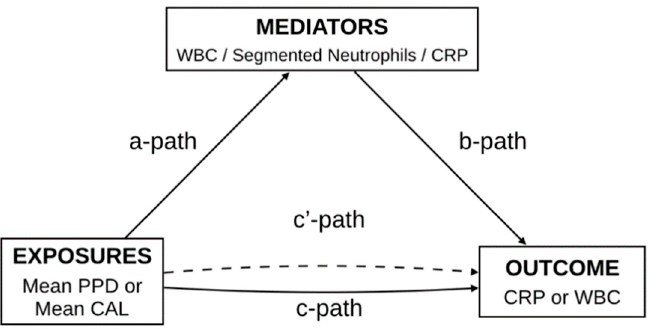
Figure 1. Path diagram of the mediation analysis models. CAL—Clinical Attachment Loss; CRP—C- Figure 1 . Path diagram of the mediation analysis models. CAL – Clinical Attachment Loss; CRP – reactive protein; PPD—Periodontal probing depth; WBC—White blood cells C-reactive protein; PPD – Periodontal probing depth; WBC – White blood cells counts